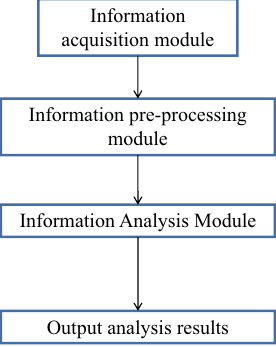
Figure 2: Cloud computing platform